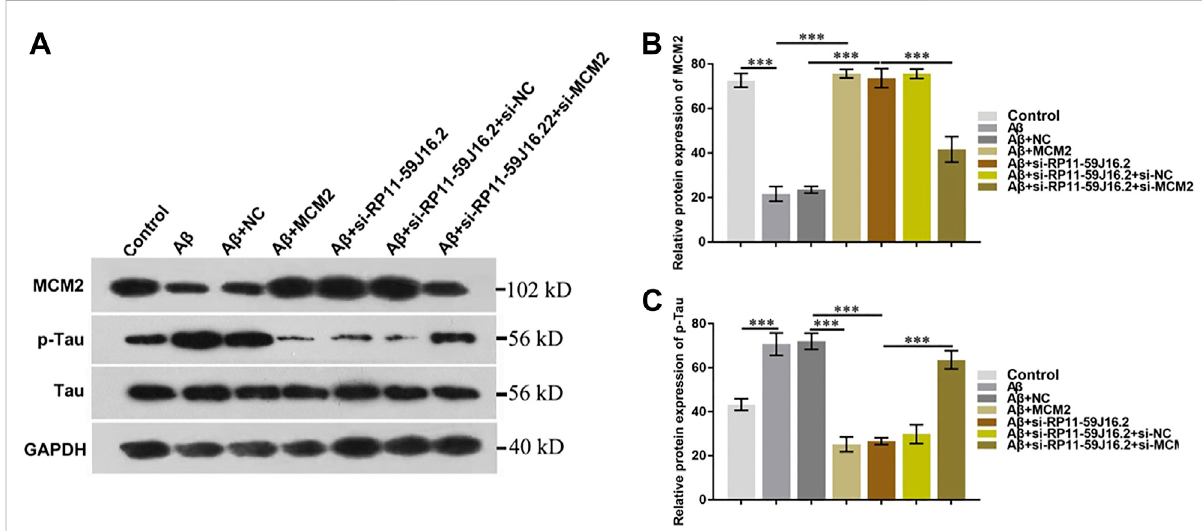
FIGURE 6 RP11-59J16.2 regulate p-Tau expression by inhibiting MCM2. (A) Western blot was used to detect p-Tau and MCM2 expression in each group. p-Tau expression was signi fi cantly decreased after transfection with si-RP11-59J16.2 or MCM2. The expression of p-Tau increased signi fi cantly in si-RP11-59J16.2 + si-MCM2 transfection group compared with si-RP11-59J16.2 or MCM2 group. The expression of p-Tau and MCM2 was negatively correlated. (B,C) Quantitative results of Western blot about the relative expression of MCM2 and p-Tau. The experiment was repeated three times in each group, *** p <